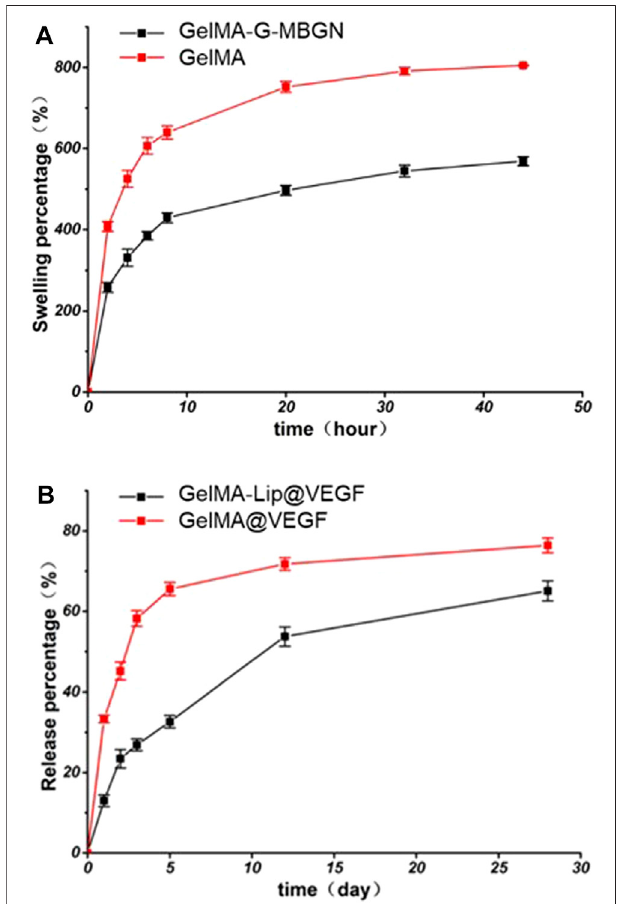
FIGURE 4 | Characterization of the swelling behavior and drug release pro fi le. (A) Swelling kinetics of hydrogels. (B) VEGF release pro fi le from the